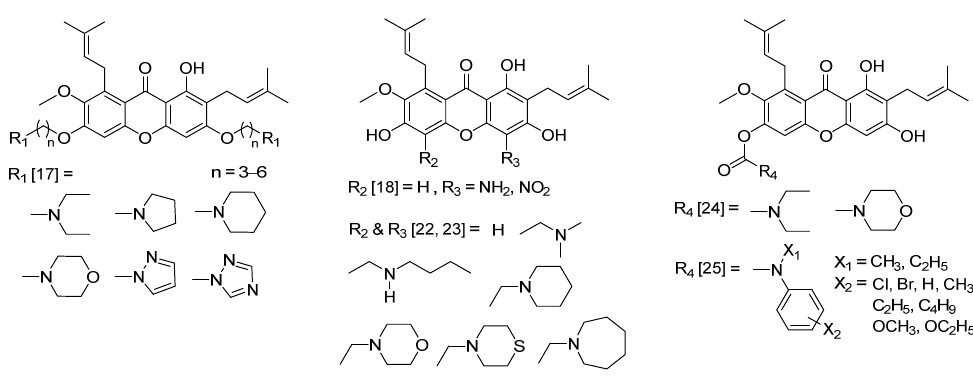
Figure 1. Synthetic N -containing α -mangostin analogs [17,18,22–25].